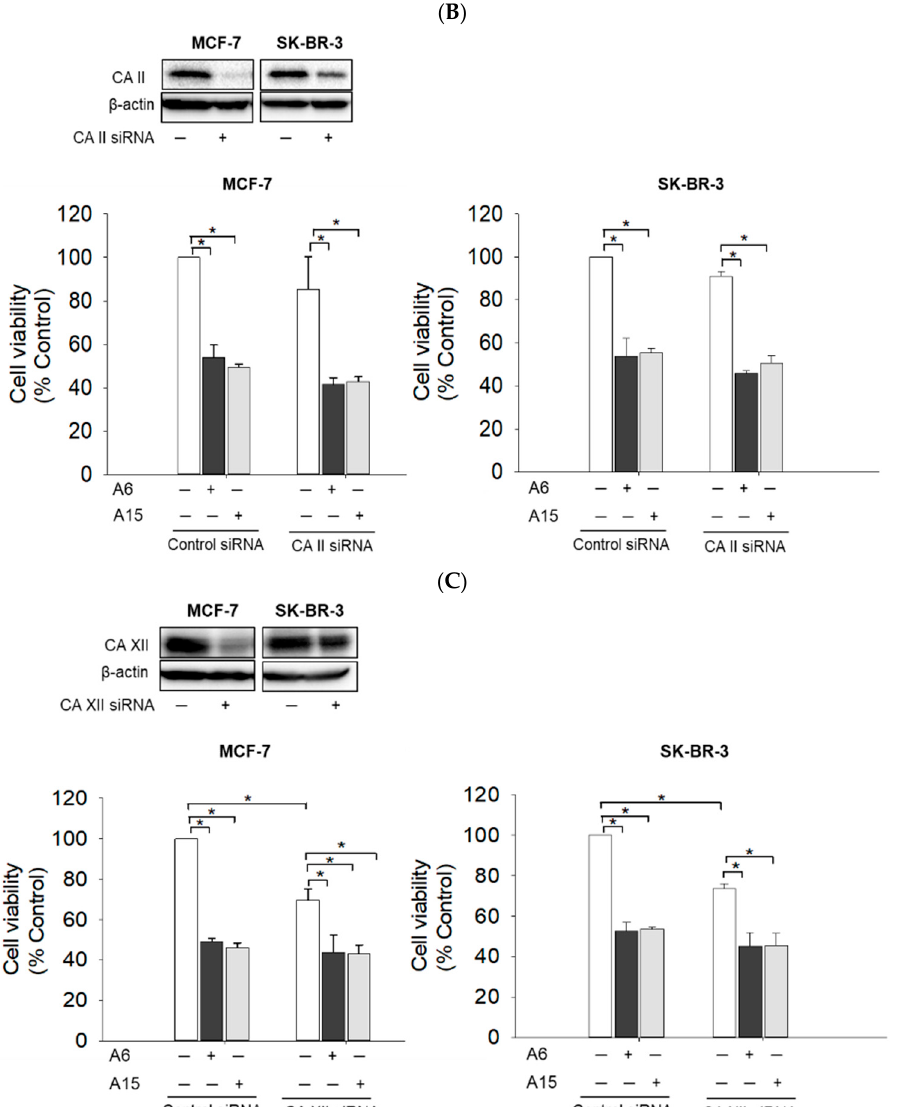
Figure 6. Effects of A6 and A15 on the viability of MCF-7 and SK-BR-3 cells transfected with siRNA targeting CA IX, II, or XII. MCF-7 and SK-BR-3 cells were transfected with control siRNA or siRNA targeting ( A ) CA IX, ( B ) CA II, and ( C ) CA XII. Western blotting analyses were performed as described in the Materials and Methods to confirm the efficiency of the respective knockdown. Representative blots are shown. Transfected cells were exposed to A6 or A15 at 50 µ M for 48 h. Control cells were treated with the media containing 0.1% DMSO instead. Cell viability was determined by MTT assay as described in the Materials and Methods and expressed as a percentage of the control measured in the vehicle (DMSO)-treated cells transfected with control siRNA. Data are displayed as mean ± SEM from at least three independent experiments. * p < 0.05 vs. the vehicle-treated control cells transfected with control siRNA. ns, not significant.